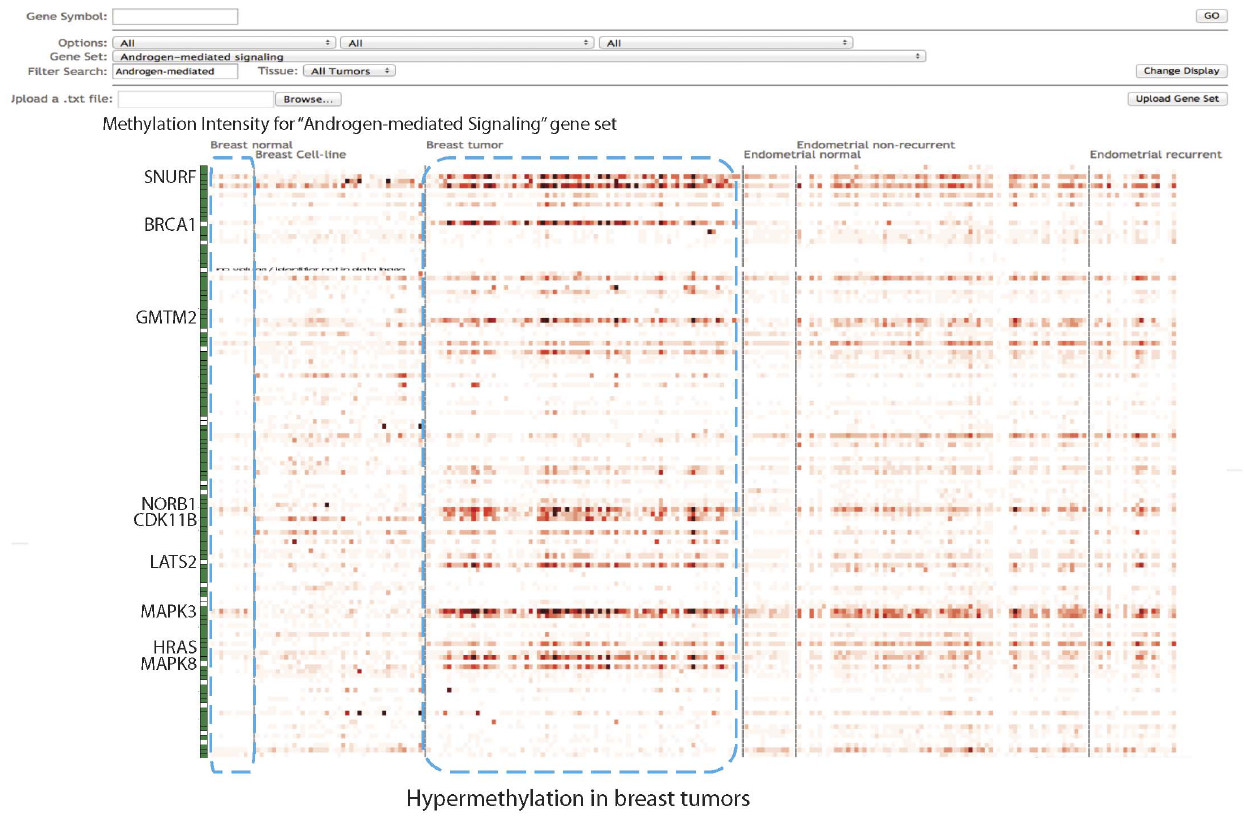
Figure 5. Discovery of differentially methylated gene sets within a pathway. The ‘‘Androgen-mediated Signaling’’ gene set which contains HOX cluster genes were selected as an example. Several genes within the blue dash box are hypermethylated in breast tumors compared to normal tissues, while others show no significant difference. For endometrial samples, no significant difference is found for any of the gene between tumors and normals.